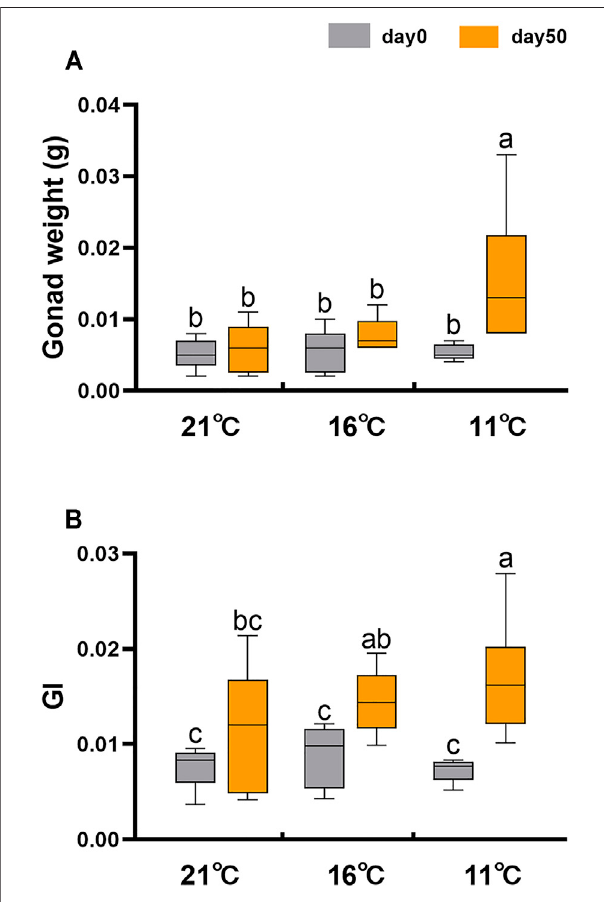
FIGURE 2 | Gonad weight and gonadal index (GI) of juvenile scallops on day 0 and 50 at three different temperatures (21, 16 and 11 ° C). The vertical barsrepresentthemeans ± SEM(N (cid:1) 5 – 6).One-wayANOVAfollowedbyLSD test was performed to compare the differences among groups. Different letters indicate signi fi cant differences ( p < 0.05).